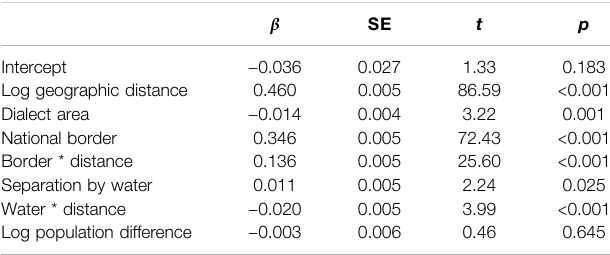
TABLE 12 | Linear mixed-effect modelling results for the Clothing and personal hygiene domain, showing beta coef fi cients, standard errors, t-values and signi fi cance